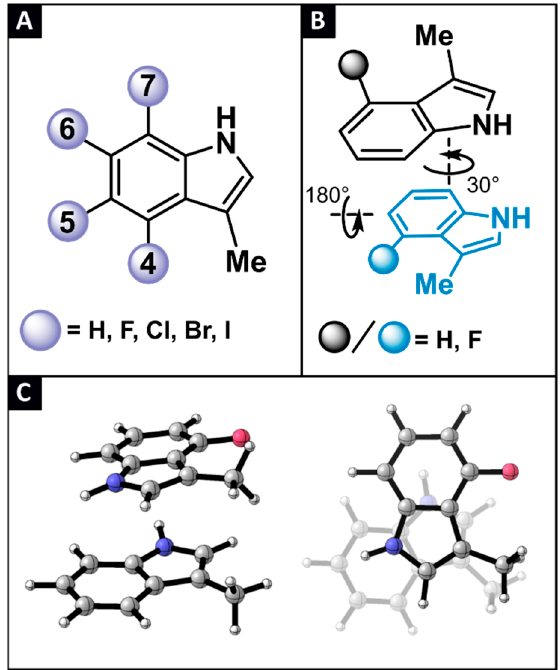
Figure 3. ( A ) A total of 17 monohalogenated 3-methylindole derivatives are considered in this study. ( B ) Schematic representation of the conformational scan performed to locate the global parallel displaced minimum. ( C ) Side- and top-view of the most stable parallel-displaced conformation found for the H-4F dimer.